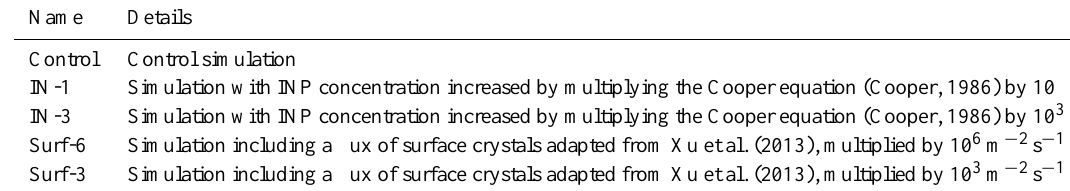
Table 1. Summary of WRF simulations used in this